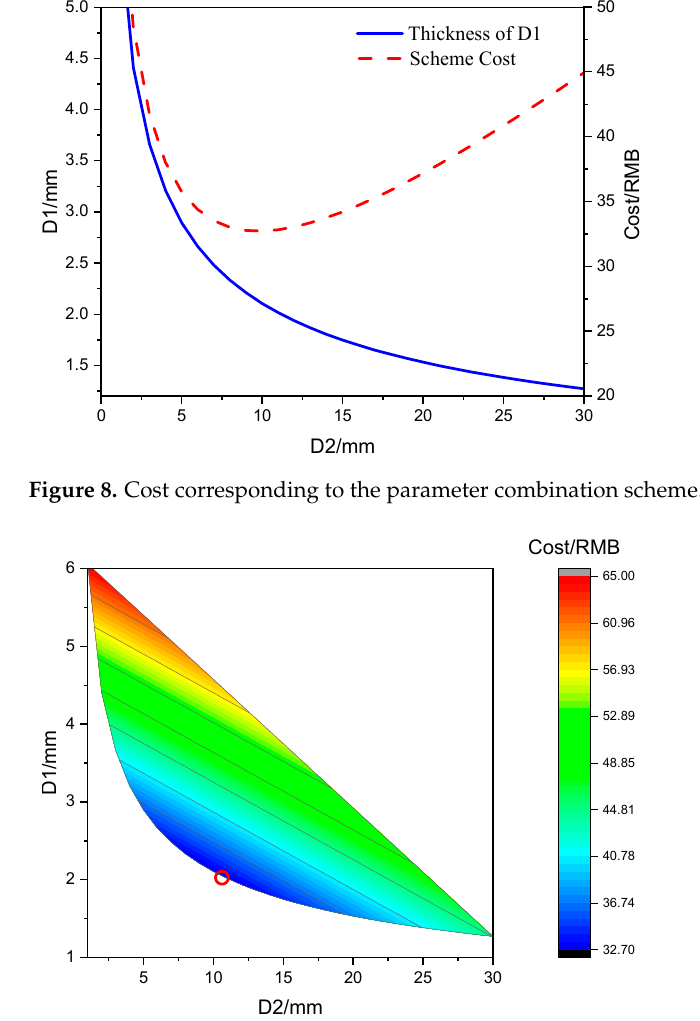
Figure 9. Cost diagram meeting the parameters of 22 dB (A) sound insulation. Table 4. Optimal parameter combination of polyvinyl chloride and non-woven fiber (sound trans- mission loss of 22 dB (A)).